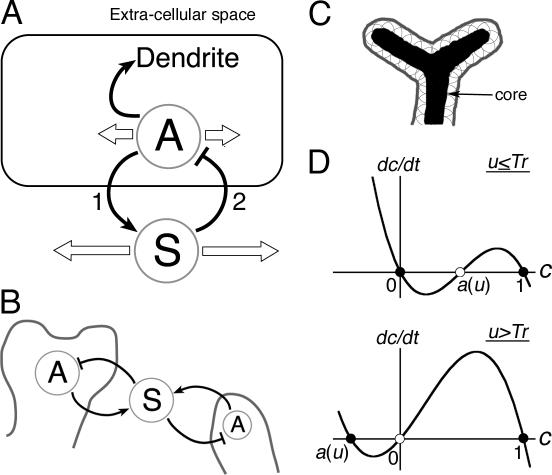
Schematic Representation of the Cell Compartment Model(A,B) An activator–suppressor system. Intracellular activator promotes growth of dendrite and produces the suppressor or accelerates secretion of the suppressor from intracellular organelles (“1” in (A)). On the other hand, the suppressor is secreted from the cell and diffuses in extracellular compartments. Binding of its receptor on the plasma membrane triggers signaling to inhibit synthesis of the activator (“2” in (A)). These reactions underlie inhibitory dendro-dendritic interactions (B).(C) Black: core of the cell; dark gray: cell boundary. The cell compartment is represented by collective circular domains around the core with radius R (gray circles).(D) Dynamics of core of the cell (c). The activator promotes cell growth when its concentration is higher than threshold (Tr). a(u) = 0.49 (u ≤ Tr) or a(u) = 0.49 − 2.5(u – Tr) (u > Tr). Upper graph: Both c = 0 and c = 1 are stable equilibrium points. Lower graph: When a(u) < 0, c = a(u) and c = 1 are stable equilibrium points and c = 0 becomes an unstable equilibrium point. Very small positive noise was added to c, so c → 1 quickly. These settings make it possible to store the history of growth of c, because c = 1 is a stable equilibrium point all the time.